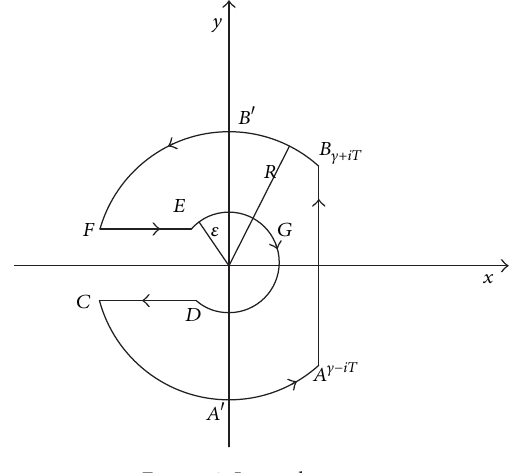
Figure 2: Integral